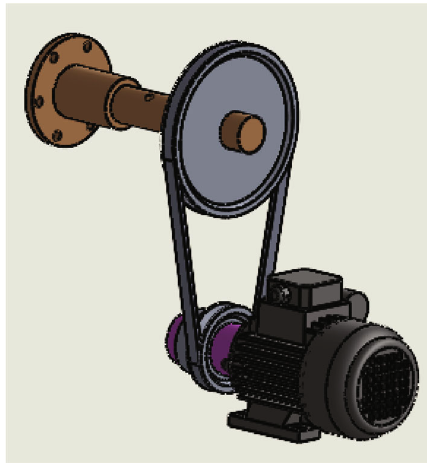
Figure 14: Power and transmission